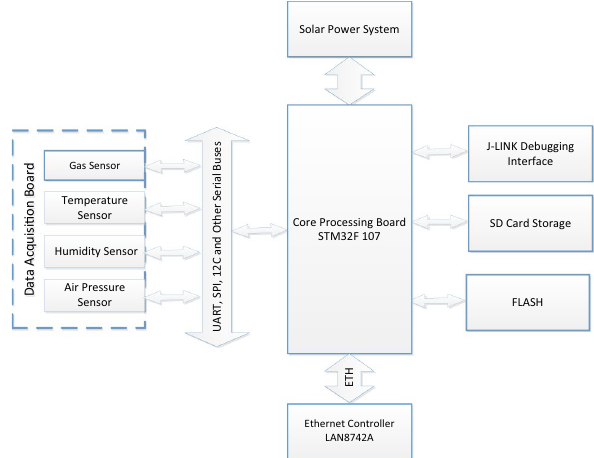
Figure 2. Hardware design framework.